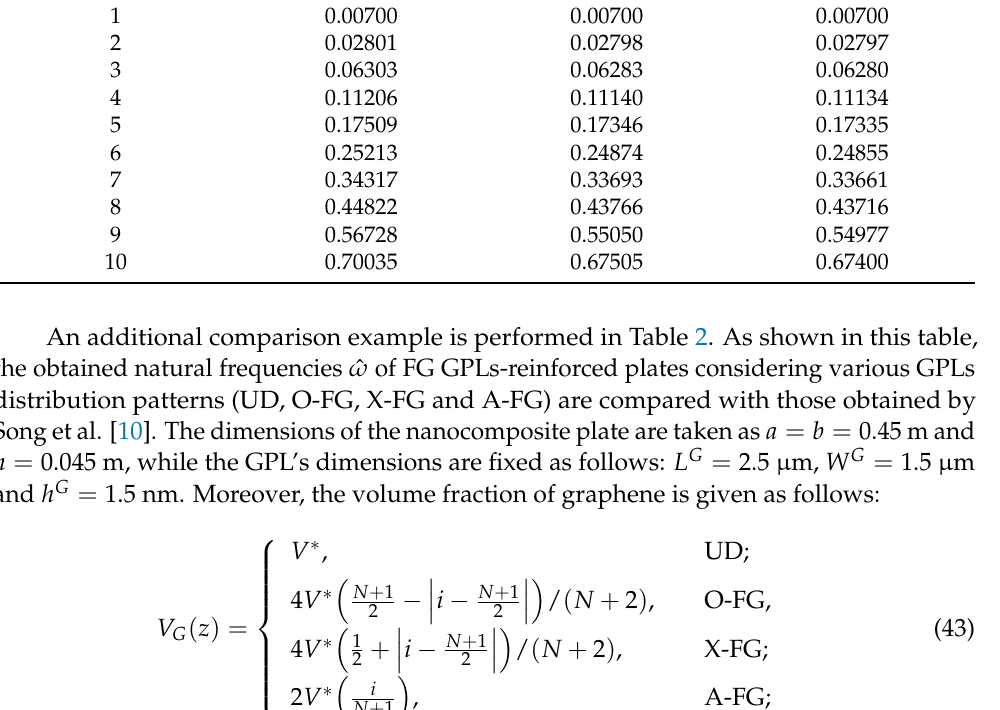
Table 1. Comparison of nondimensional wave frequency ¯ ω (THz) of a homogeneous plate for various values of wave number k ( E = 1.06 TPa, ν = 0.25, ρ = 2250 kg/m 3 , h = 0.34 × 10 − 9 ). k (10 8 /m) Ref. [64] Ref. [63] Present